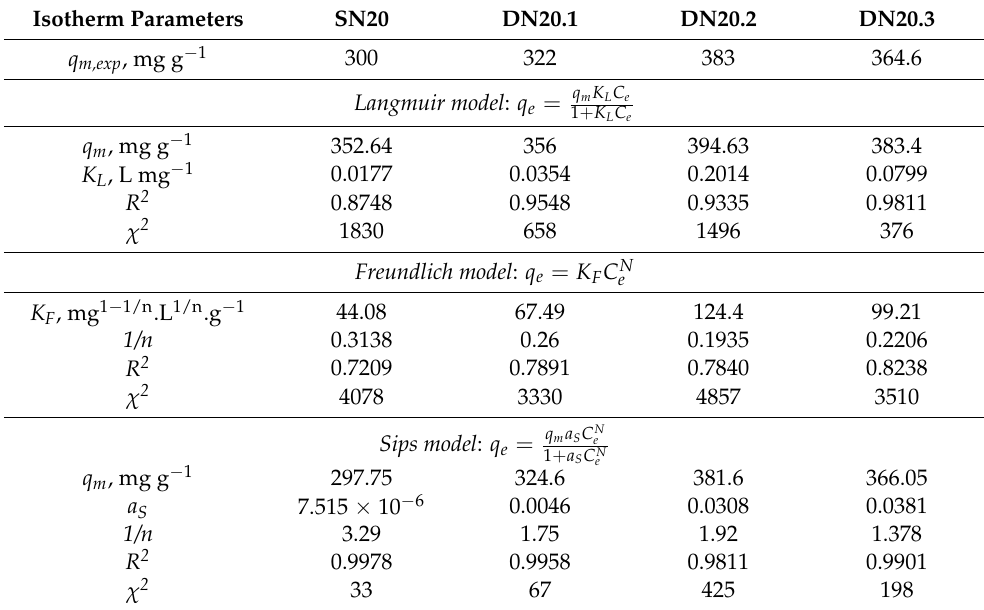
Table 4. Isotherm parameters for the sorption of Cr 2 O 72 − anions onto SN20 cryogels and derived composite sorbents.